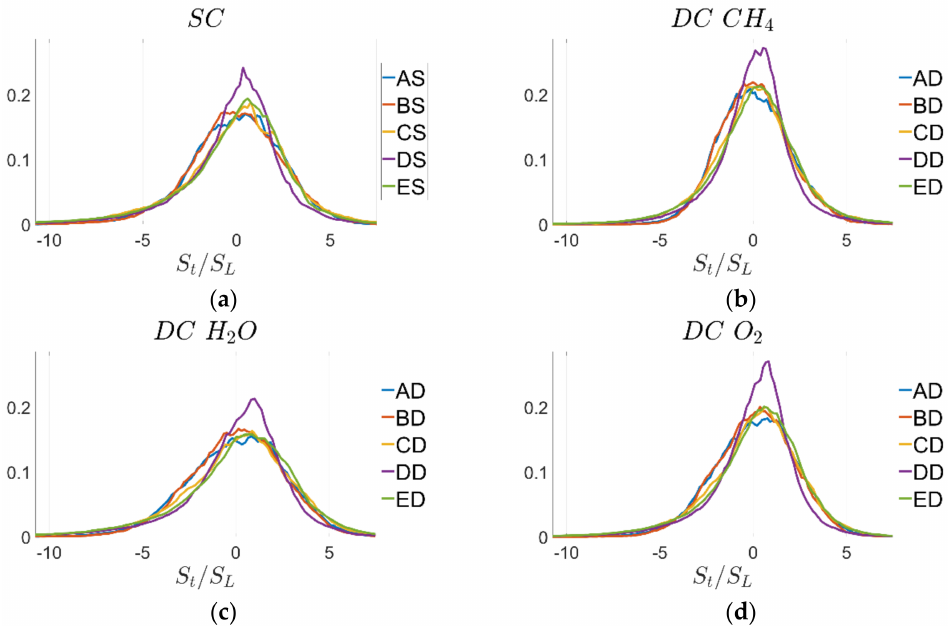
Figure 10. PDF of normalised tangential diffusion component of displacement speed S t / S L on c = 0.8 progress-variable isosurface for cases A–E for ( a ) SC and ( b – d ) DC simulations for reaction progress variable based on CH 4 , H 2 O,O 2 mass